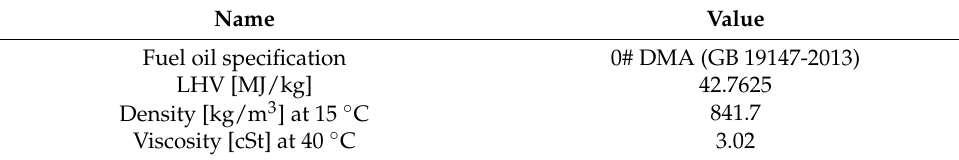
Table 3. Elemental analysis of diesel oil.